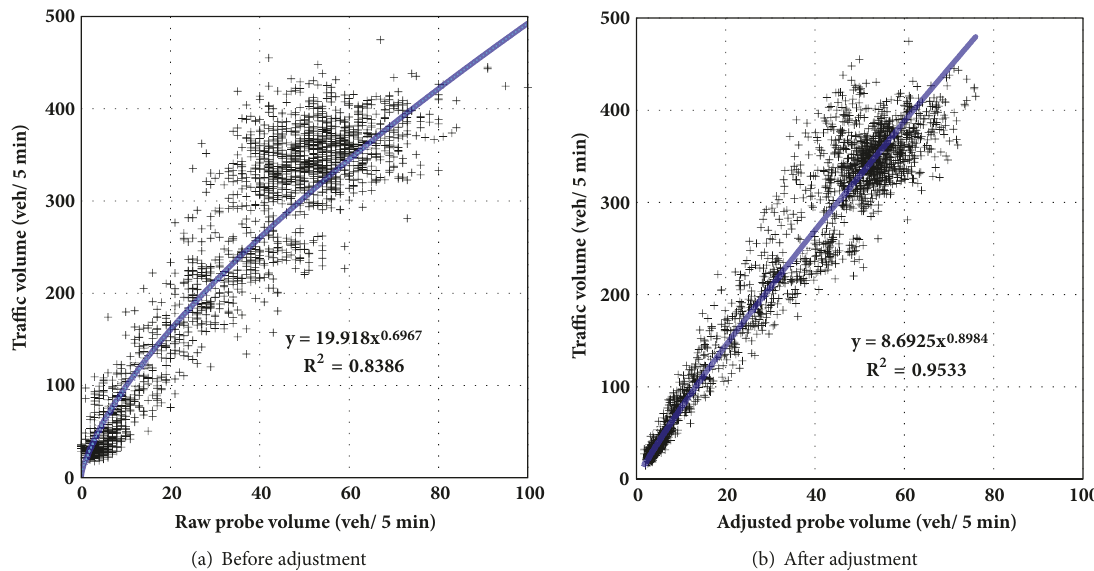
Figure 9: Efficacy of the contraction